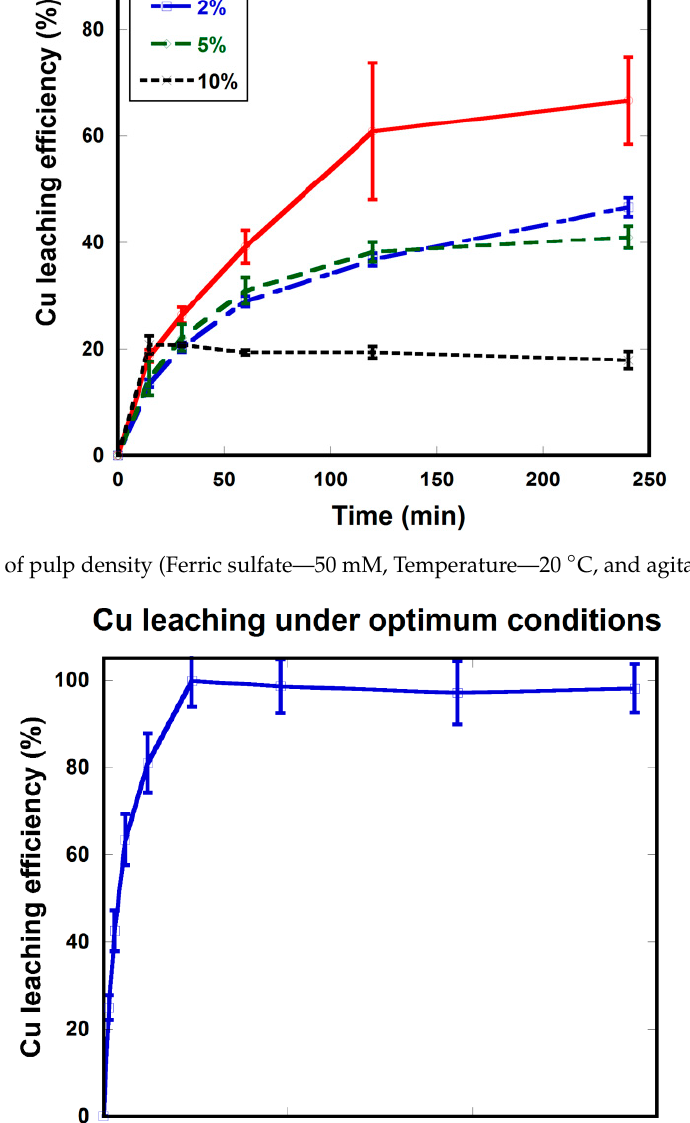
Figure 5. Leaching of Cu from PCBs under optimum conditions.